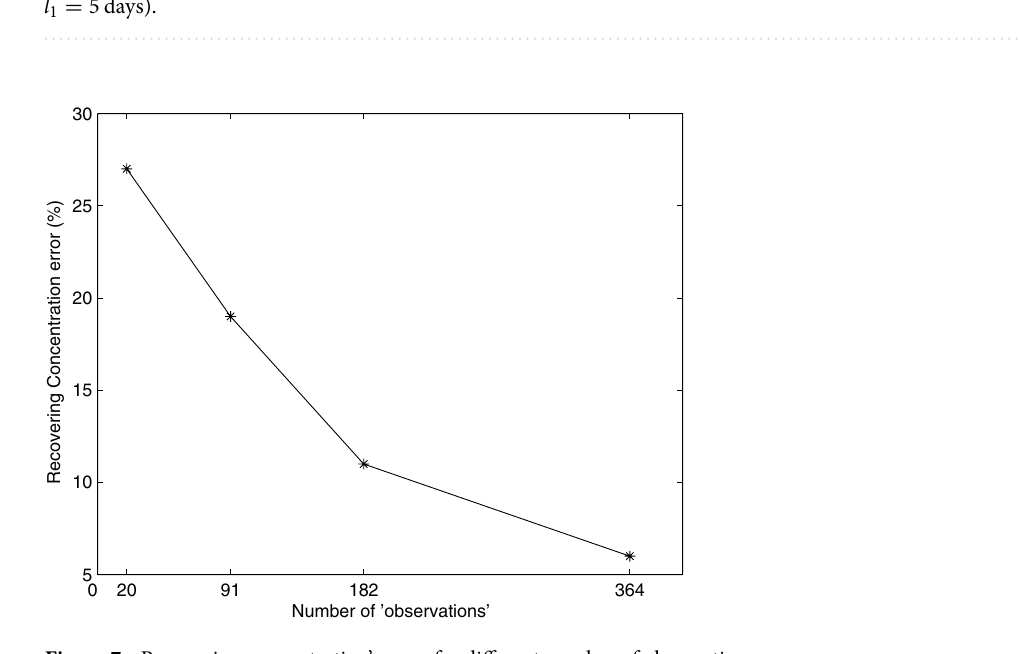
Figure 7. Recovering concentration’s error for different number of